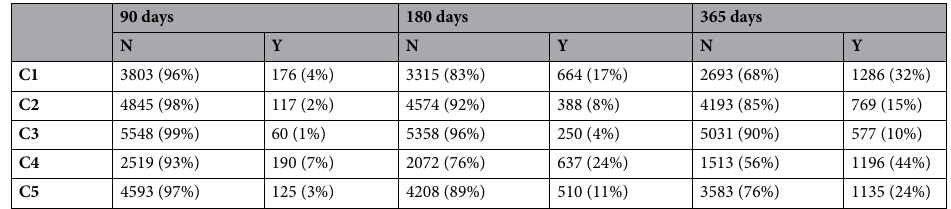
Table 4. Initial class distribution concerning each critical endpoint of interest and time windows (after snapshots creation)—N is the number of snapshots in which the patient will not evolve within the considered time window since the date of the snapshot, and Y is the number of snapshots in which the patient will evolve. C1, need for NIV; C2, need for an auxiliary communication device; C3, need for PEG; C4, need for a caregiver and C5, need for a wheelchair.